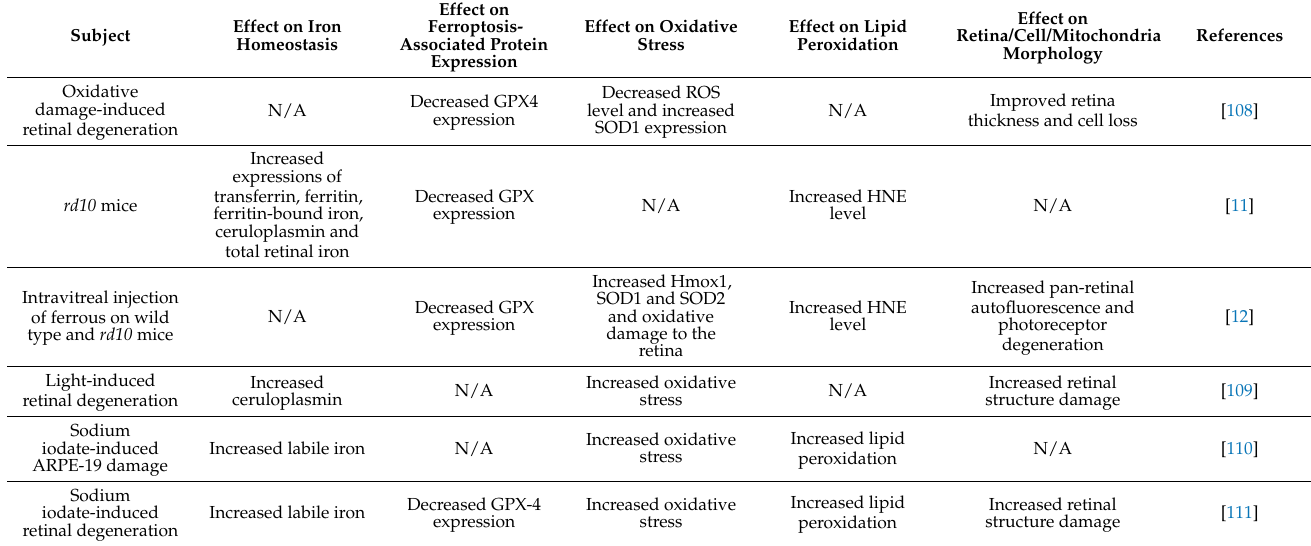
Table 3. Evidence supporting the association between retinitis pigmentosa and